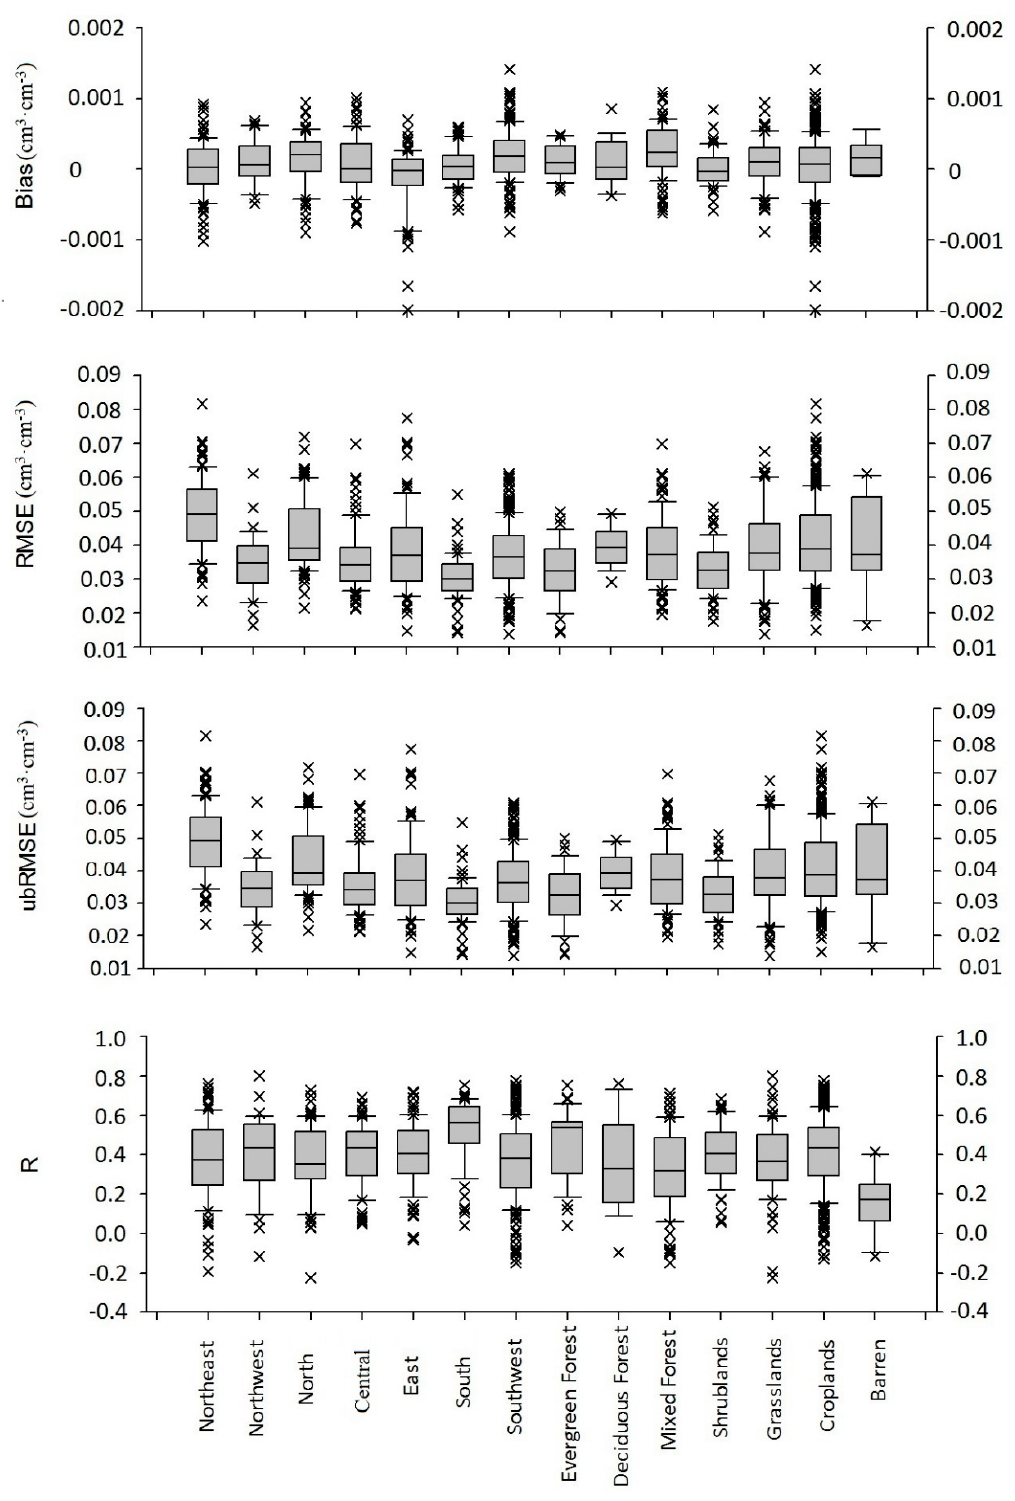
Figure 5. Evaluation of SMAP soil moisture retrievals relative to in situ soil moisture observations based on anomaly data over the different land cover types and geographical zones in continental China. The presented data are the median (the horizontal line inside each box), 1st quantile Q1, and 3rd quantile Q3 (the bottom and top of the box, respectively), and the 90th and 10th percentiles (the whiskers, i.e., error bars, above and below the box).